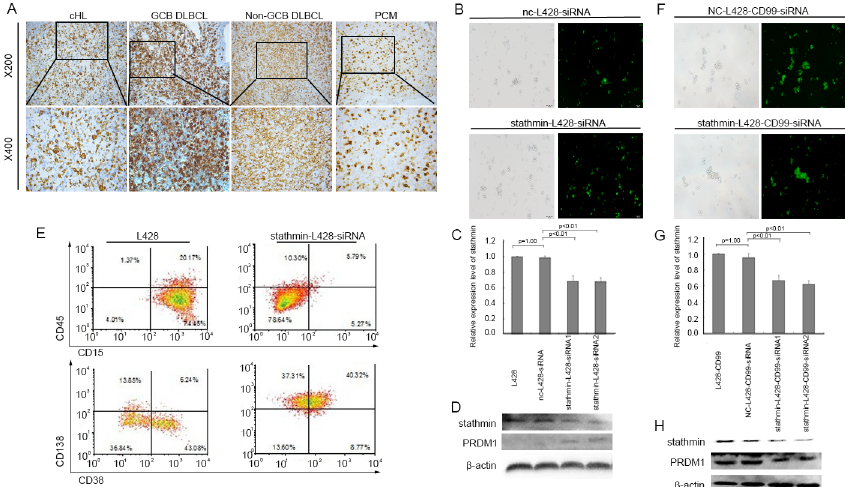
Fig 5. STATHMIN was involved in the differentiation of B-cells. (A) IHC analysis of STATHMIN expression in different types of lymphomas (cHL, GCB-DLBCL, Non-GCB DLBCL, and PCM) (B) Morphological images of L428 cells transfected with STATHMIN - siRNA. Left panel: light image, Right panel: fluorescent image. Original magnification ×100. (C) Relative expression level of STATHMIN in L428 transfected with STATHMIN -siRNA for 24h by qRT-PCR. (D) Western blot of PRDM1 expression in L428 cells transfected with STATHMIN -siRNA for 96h. (E) Flow cytometry analysis of the surface expression of B- cell differentiation antigens in L428 cells transfected with STATHMIN -siRNA for 96h. (F) Morphological images of L428- CD99 cells transfected with STATHMIN -siRNA. Left panel: light image, Right panel: fluorescent image. Original magnification ×100. (G) Relative expression levels of STATHMIN in L428- CD99 transfected with STATHMIN -siRNA for 24h by qRT-PCR. (H) Western blot of PRDM1 expression in L428- CD99 cells transfected with STATHMIN -siRNA for